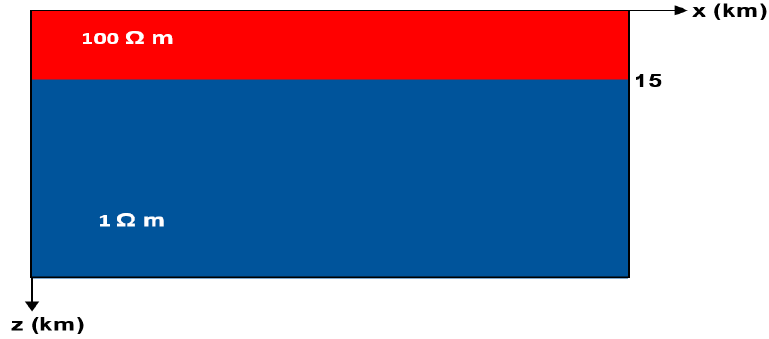
Figure 2. Vertical cross-section view of the model 1 with the anomaly in a homogeneous half-space.